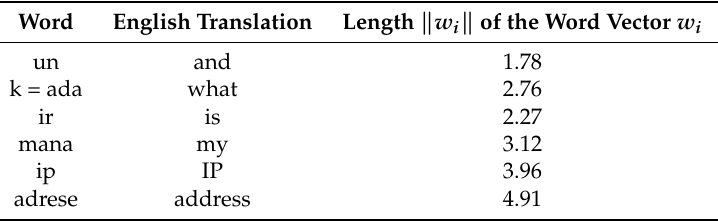
Table 4. Lengths of the word embeddings